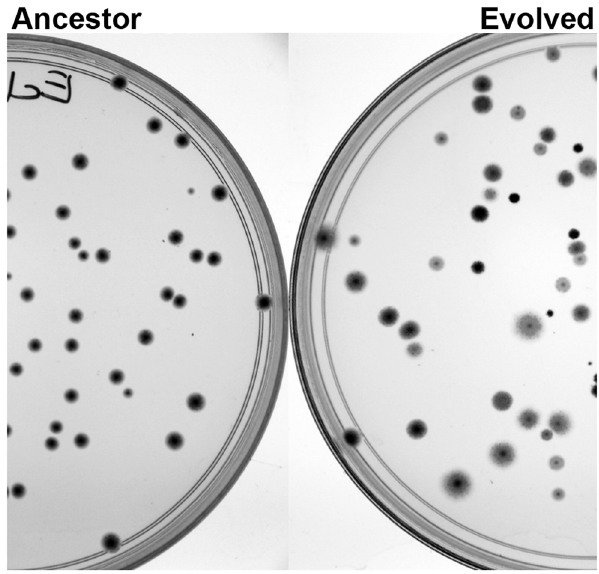
Fig. 2. The underlying genetic diversity of the adapted populations is readily observed as phenotypic diversity, when plated on tetrazolium arabinose plates. When arabinose is provided as the carbon source, the diversity of genotypes in the adapted populations is seen as a marked increase in phenotypic diversity. Colony size, morphology and the ability to use arabinose (as indicated by the darkness of the colony) varied widely in the adapted populations compared to the